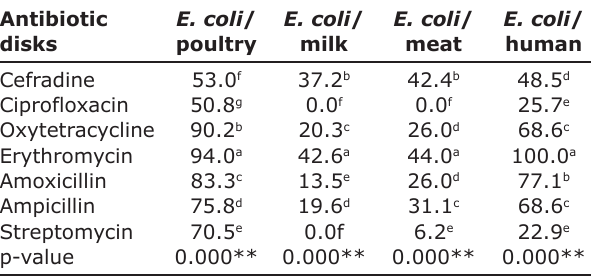
Table-12: Results of the antibiotic resistance of E. coli from all samples. Antibiotic